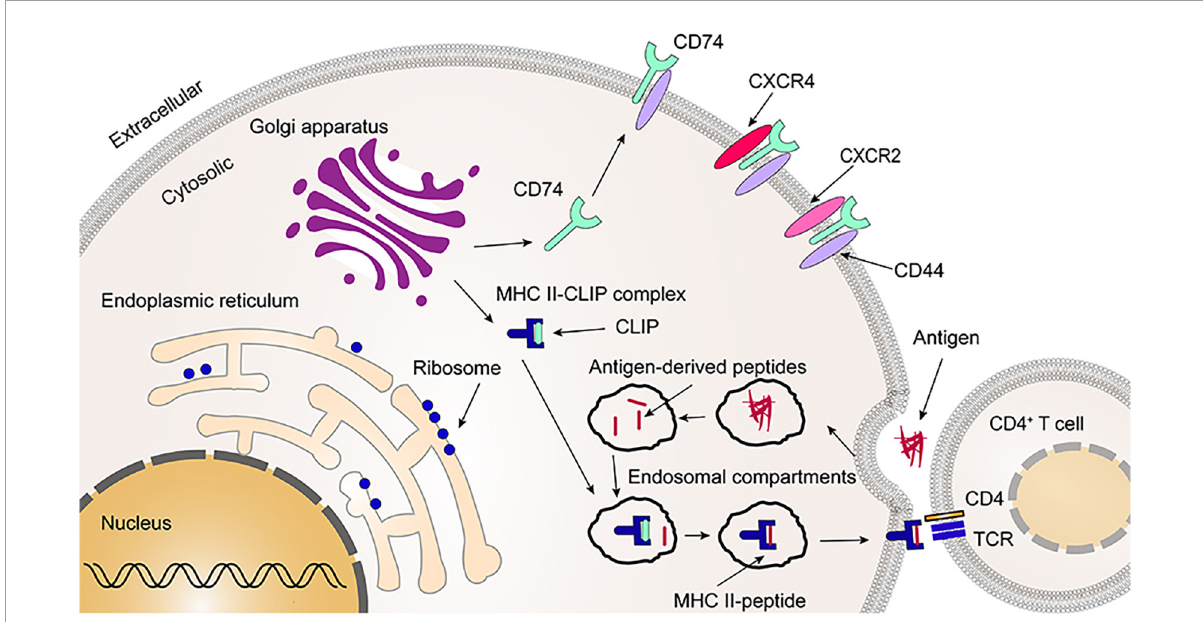
FIGURE3 Primary functions of leukocyte differentiation antigen 74 (CD74). The CD74 is released to the cell surface following synthesis, folding, and trimerization (2–5%). Together with CD44, CXCR2 and CXCR4, CD74 serves as a receptor for migration inhibitory factor (MIF) and MIF2. As most of CD74 occupies the binding groove of major histocompatibility complex class II (MHC II), it prevents the binding of endogenous polypeptide molecules to MHC II in the endoplasmic reticulum. Afterwards, CD74 is partially cleaved, leaving the CLIP fragment that protects the binding groove of MHC II. Once the CLIP fragment is released, the exogenous peptide can be loaded into the binding groove of the MHC II and form the MHC II-peptide. Finally, CD4 + T cells recognize the MHC II-peptide on the cell membrane. CLIP, the class II-associated invariant chain peptides; TCR, T-cell